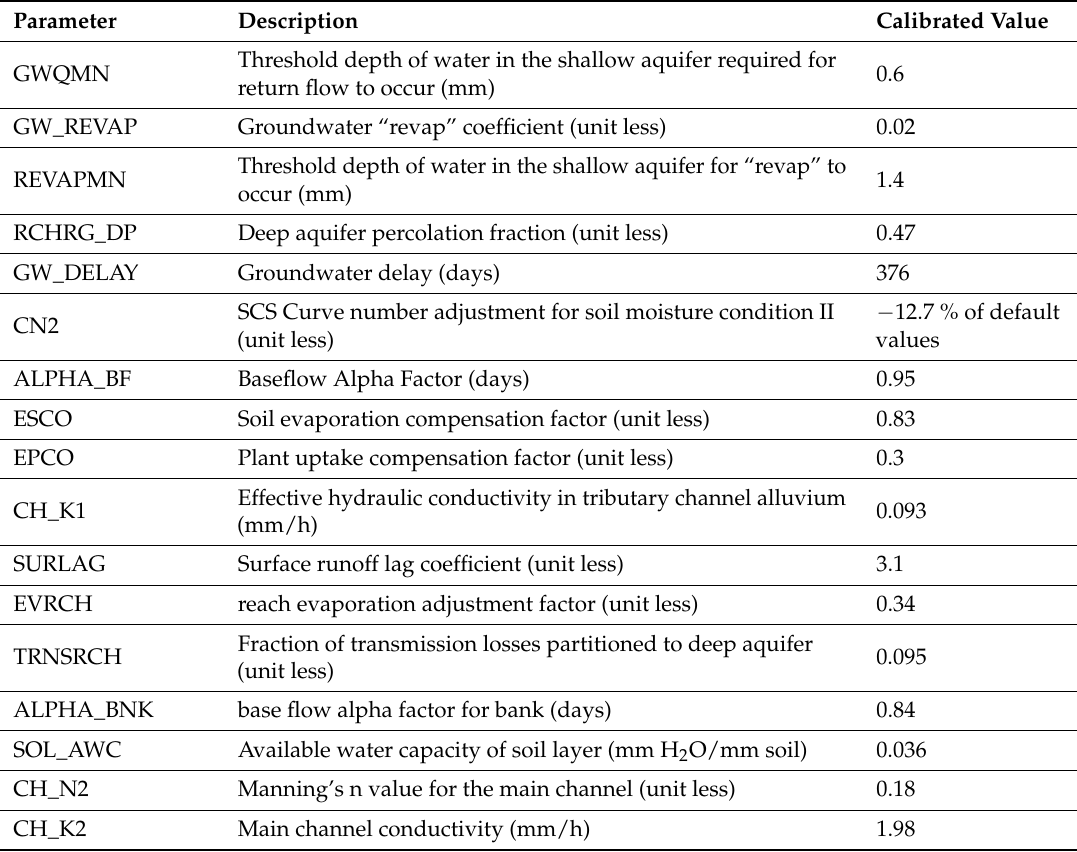
Table 1. Model parameters with the calibrated values for streamflow in the study